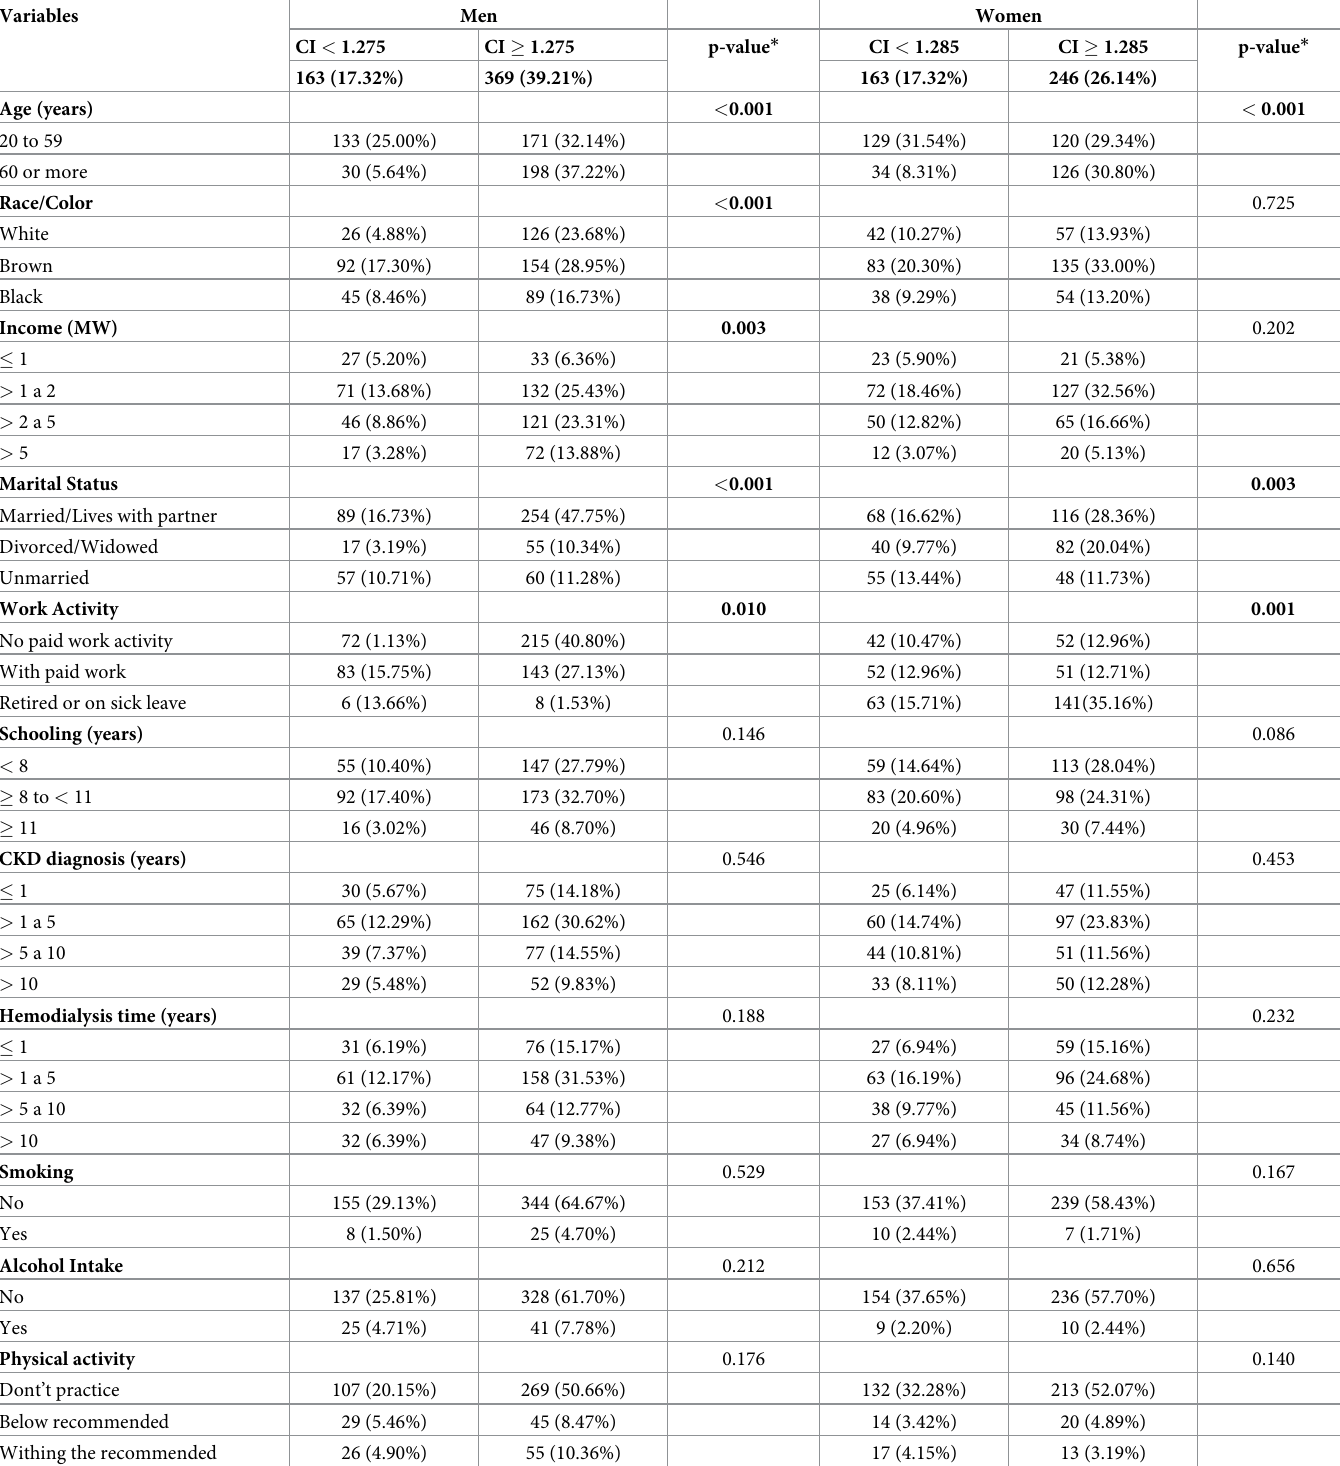
Table 1. Comparison of sociodemographic and clinical indicators and lifestyle habits according to the conicity index stratified by sex of individuals on